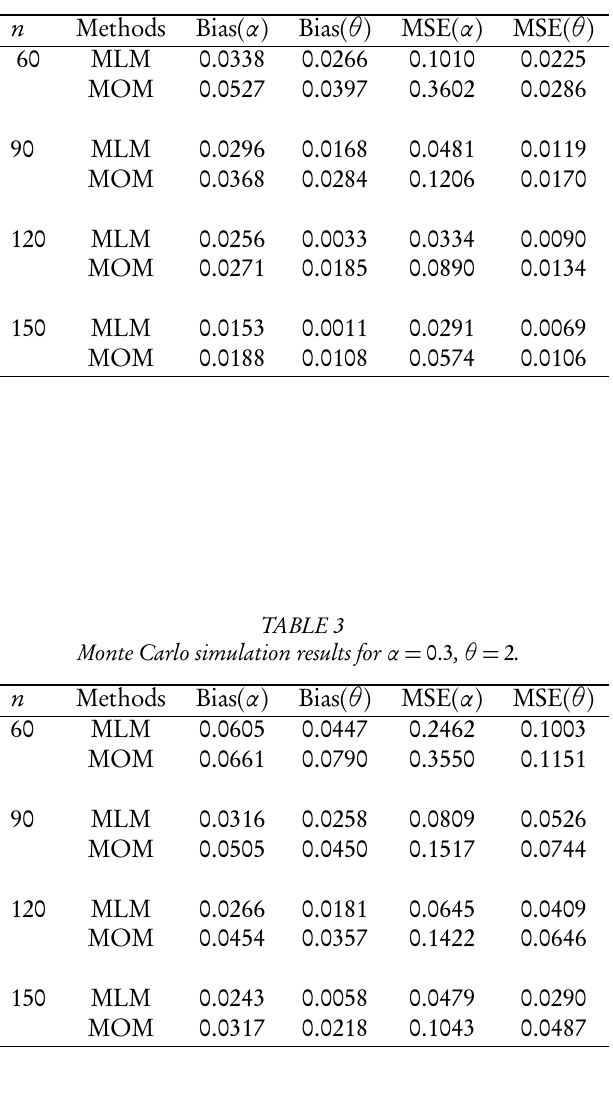
Monte Carlo simulation results for α = 0.2 , θ = 1 .